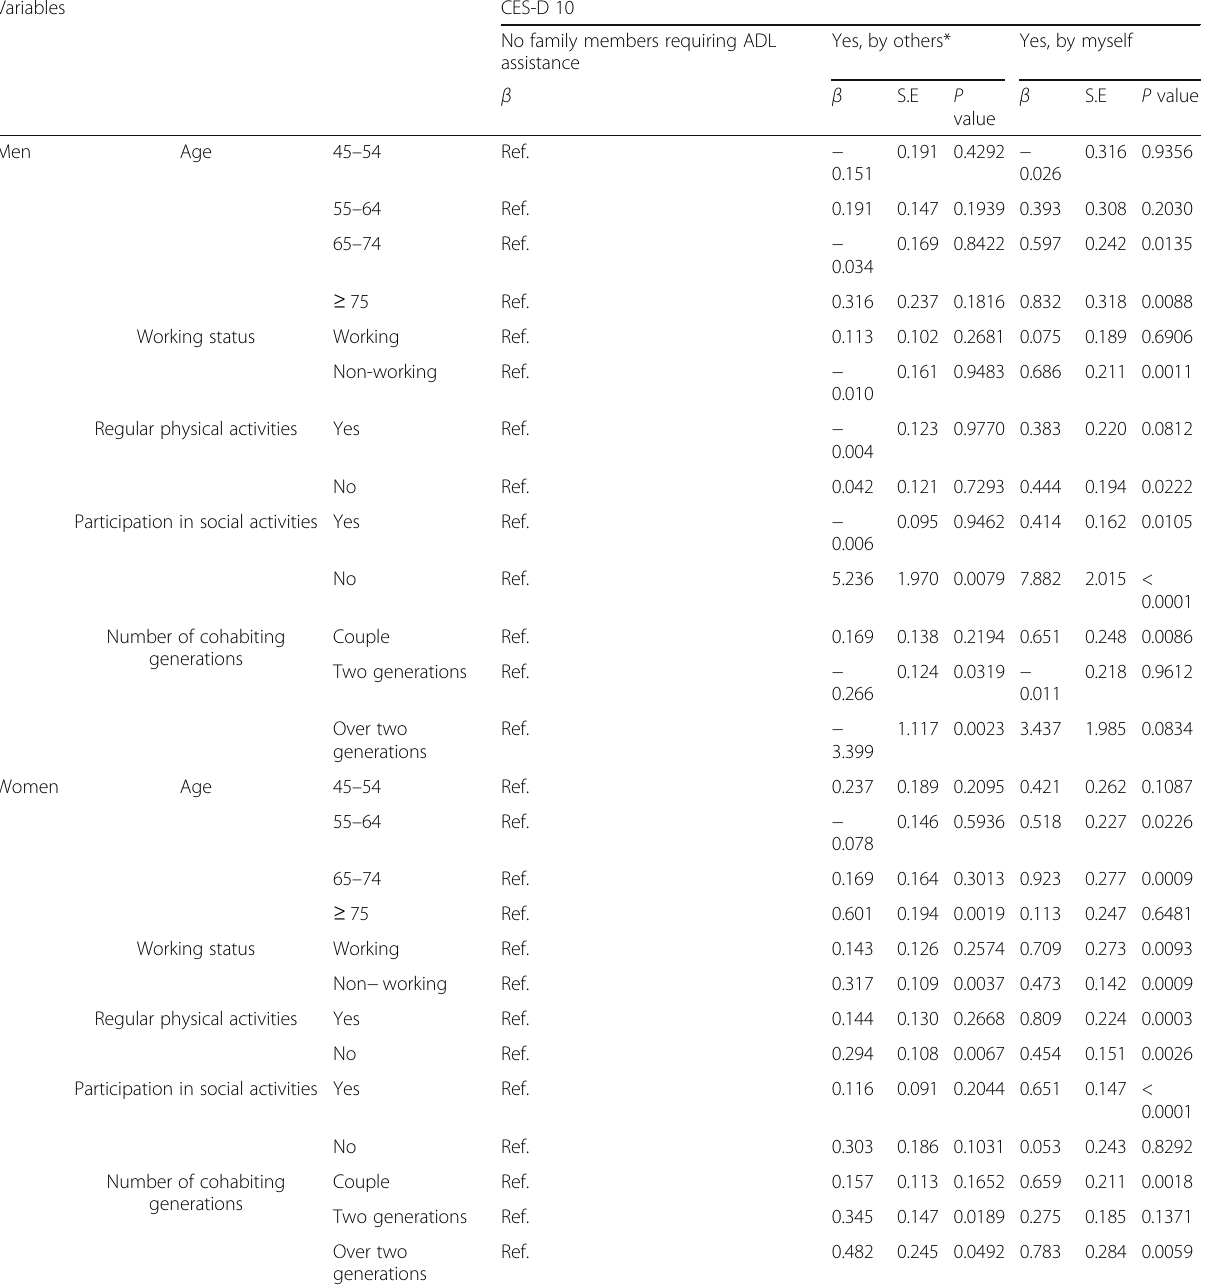
Table 3 Results of subgroup analysis of caregiving for ADL family members with CES-D 10